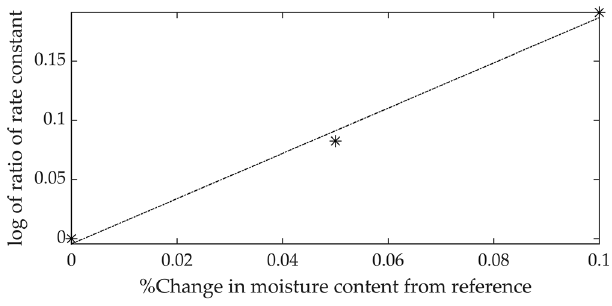
Figure 5. Variation of rate constant ratio, k m , with changes in initial moisture content, (cid:31) MC i